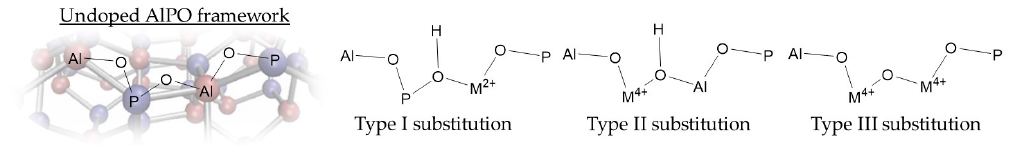
Figure 3. Three mechanisms of isomorphous substitution are observed for AlPO frameworks, depending on the formal charge of the dopant atom. M 2+/3+ species tend to undergo Type I substitution of Al 3+ , whereas M 4+/5+ preferentially replace P 5+ by Type II. If a pair of M 4+ species simultaneously substitute adjacent Al 3+ and P 5+ to create a M 4+ -O-M 4+ bridge, this is designated a Type III substitution.